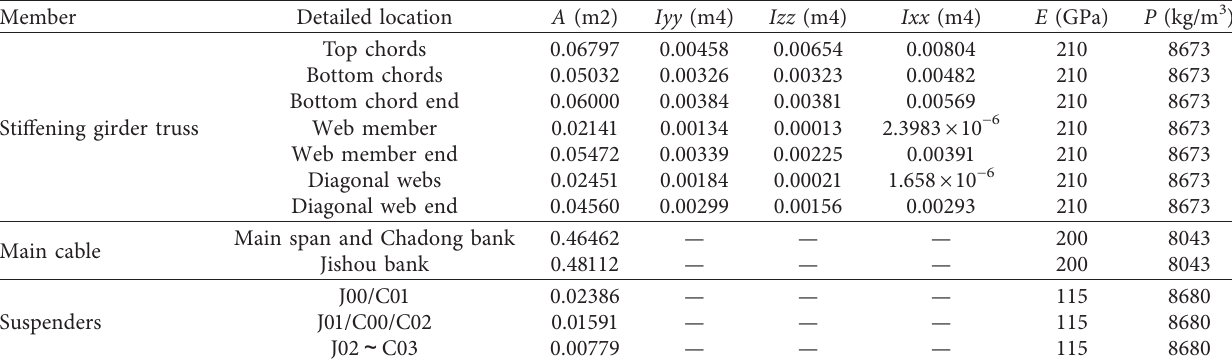
Figure 1: Aizhai Suspension Bridge (m): (a) realistic scene; (b) general layout. Table 1: Parameters for the main components of the